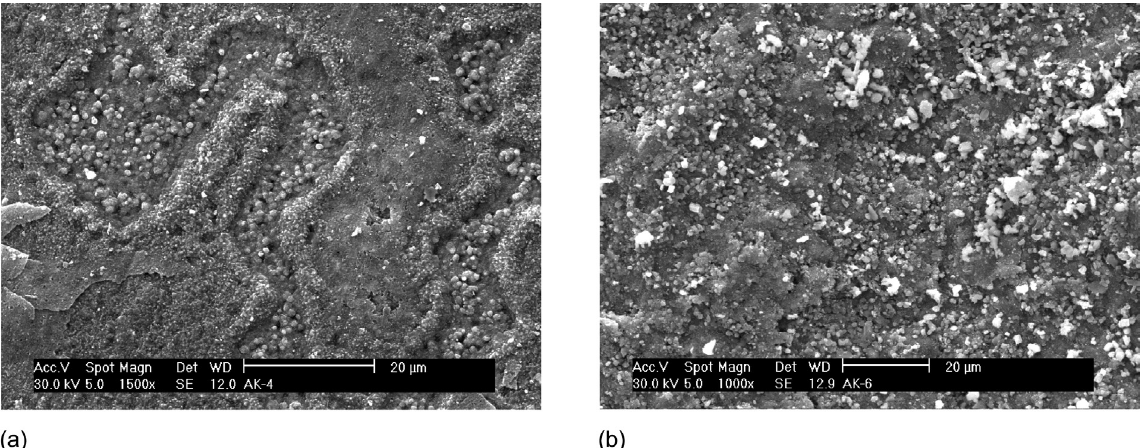
Fig. 2: (a) Wrinkling and spalling of oxide scale at 900 °C without V 2 O 5 in salt mixture. (b) Oxides scale with micro pores on the surface of the samples with V 2 O 5 in salt mixture